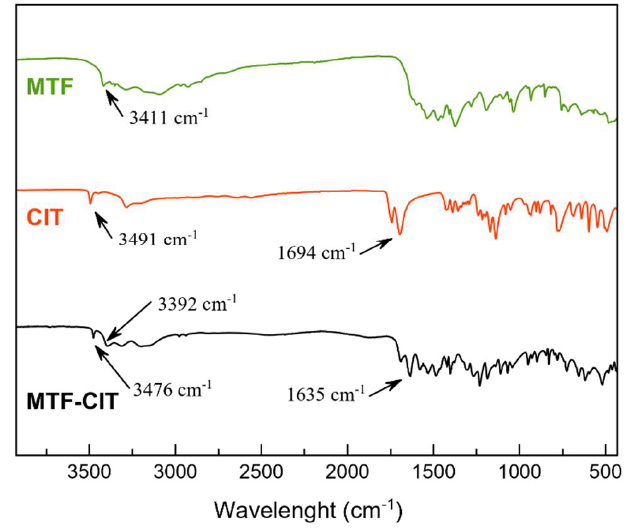
Figure 6. FT-IR spectra of MTF (green), CIT (red), and MTF–CIT (black).